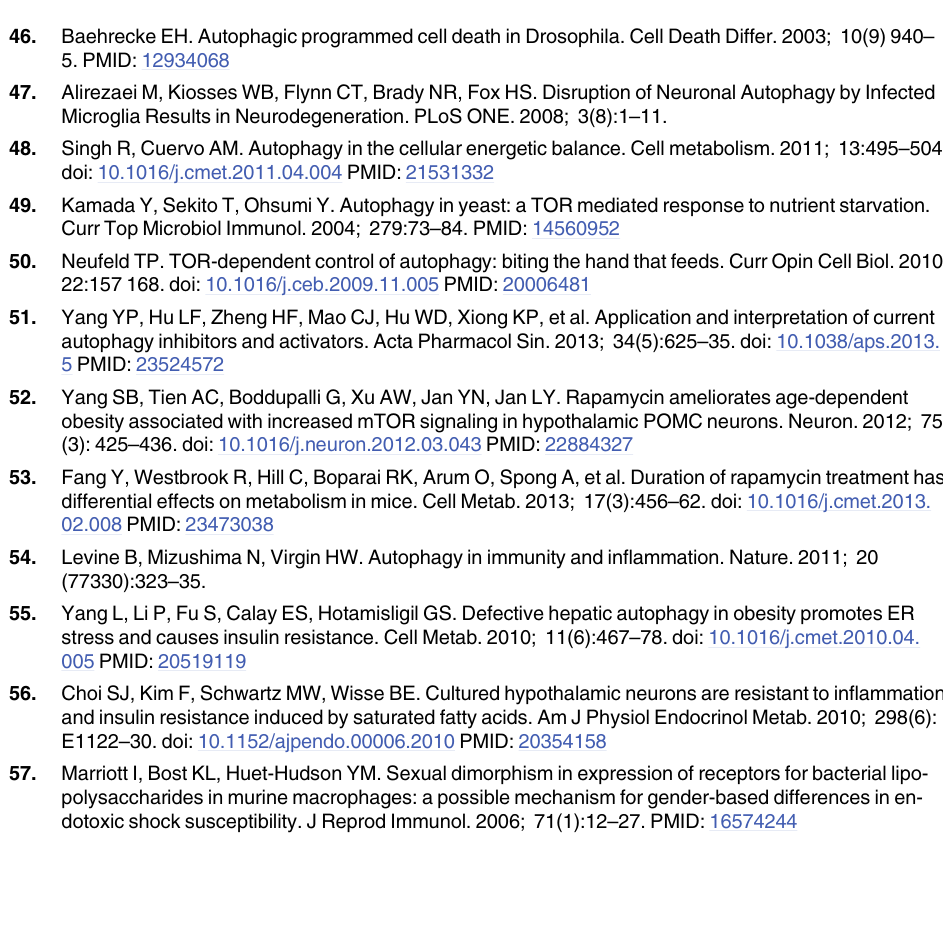
PLOS ONE | DOI:10.1371/journal.pone.0119850 March 18,